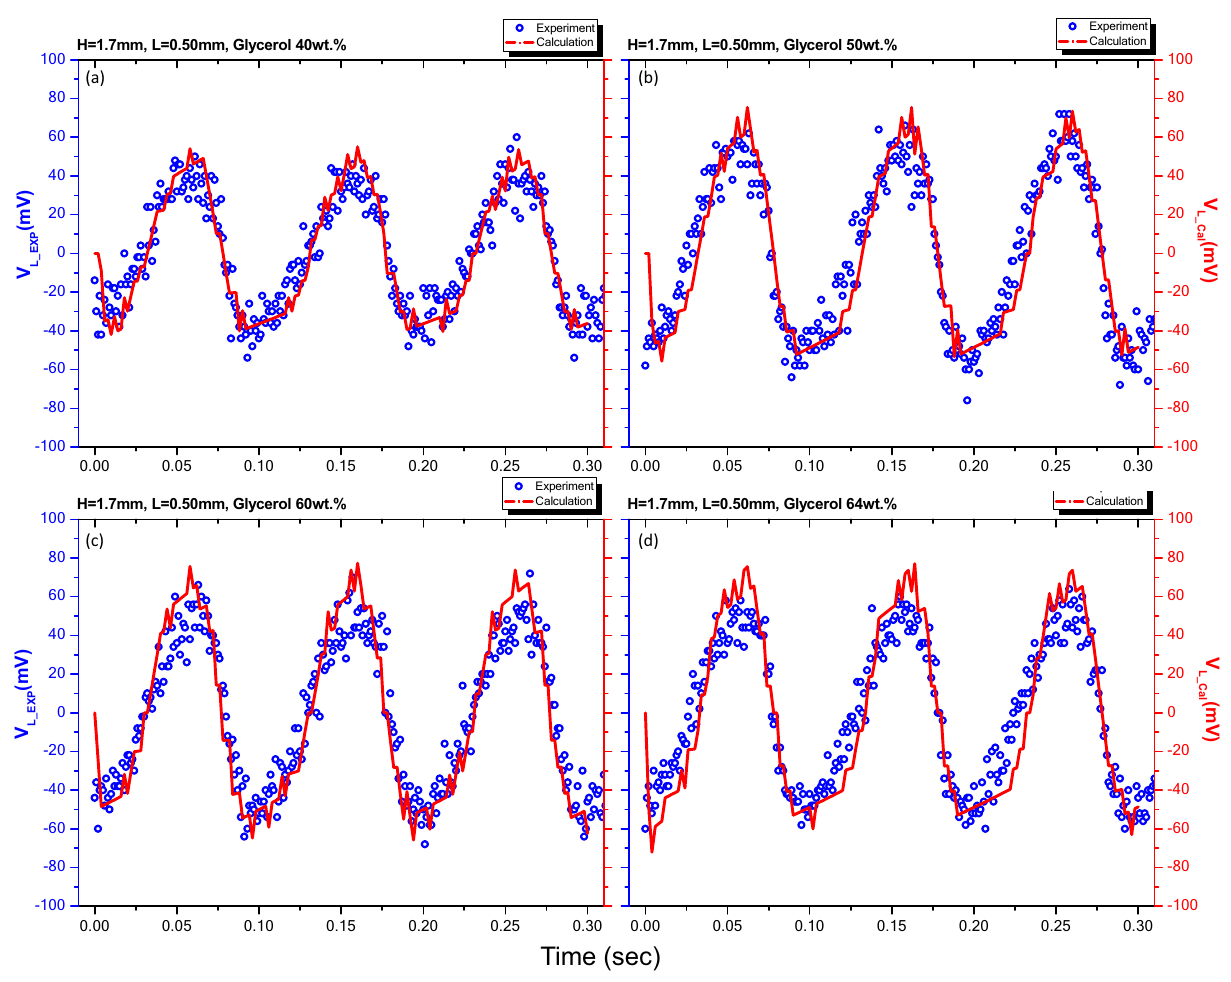
Figure 12. Comparison of the experimental results (blue circles) and predictive value (red line) of output voltage V